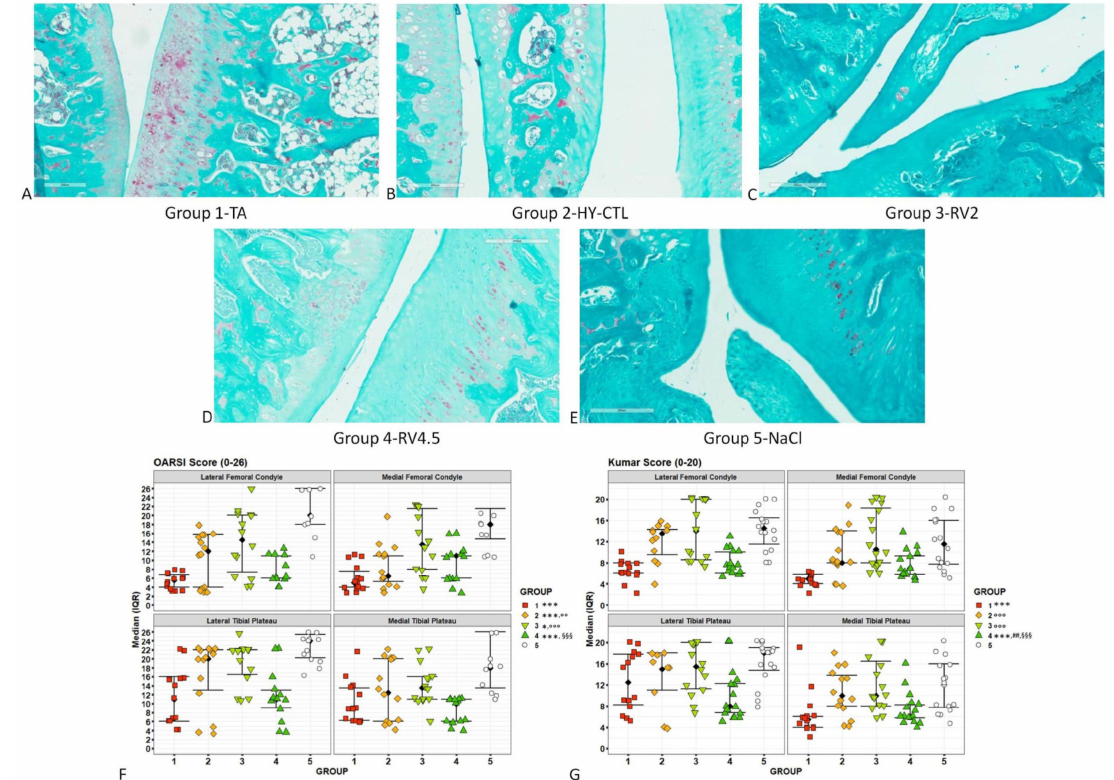
Figure 4. Histopathological assessments of right joints of rats. Histological images of the medial aspect of joints treated with i.a injection of TA ( A ), HY-CTL ( B ), RV2 ( C ), RV4.5 ( D ) and NaCl ( E ). Safranin O / Fast Green staining. Magnification 15 × , bar = 200 µ m. ( F – G ) Scatter plots of Osteoarthritis Research Society International (OARSI) and Kumar results for each treatment group measured at the lateral (femoral condyle and tibial plateau) and medial (femoral condyle and tibial plateau) knee joint compartments; black square dots indicate the median and error bars indicate interquartile range (IQR). Post-hoc pairwise comparisons (1 symbol: p < 0.05; 2 symbols: p < 0.005; 3 symbols: p < 0.0005): * All treatment groups versus NaCl. ◦ HY-CTL, RV2 and RV4.5 versus TA. # RV2 and RV4.5 versus HY-CTL. § RV4.5 versus RV2. Group 1: TA; group 2: HY-CTL; group 3: RV2; group 4: RV4.5; group 5: NaCl. Black arrowheads: cartilage staining with Safranin O; red arrowheads: fibrillation; FB: fibrous tissue; CL: